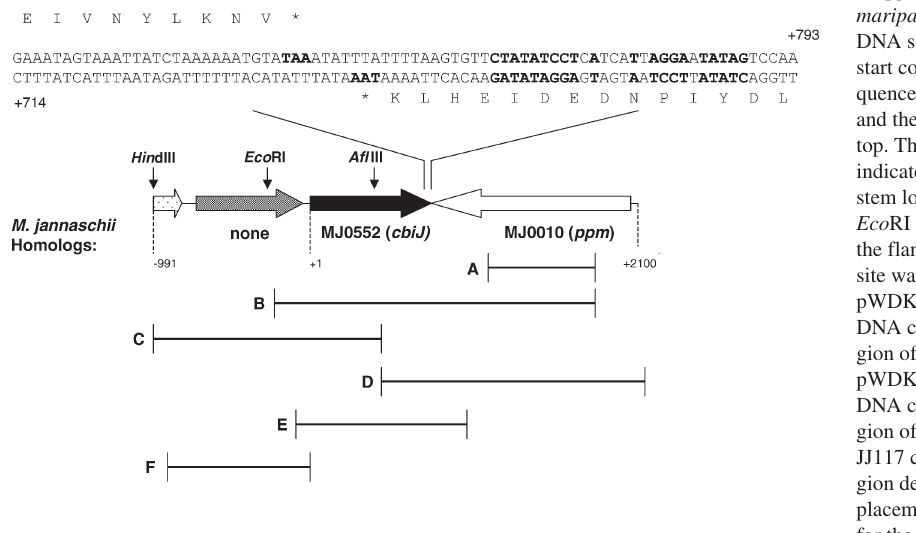
ARCHAEA ONLINE at http://archaea.ws